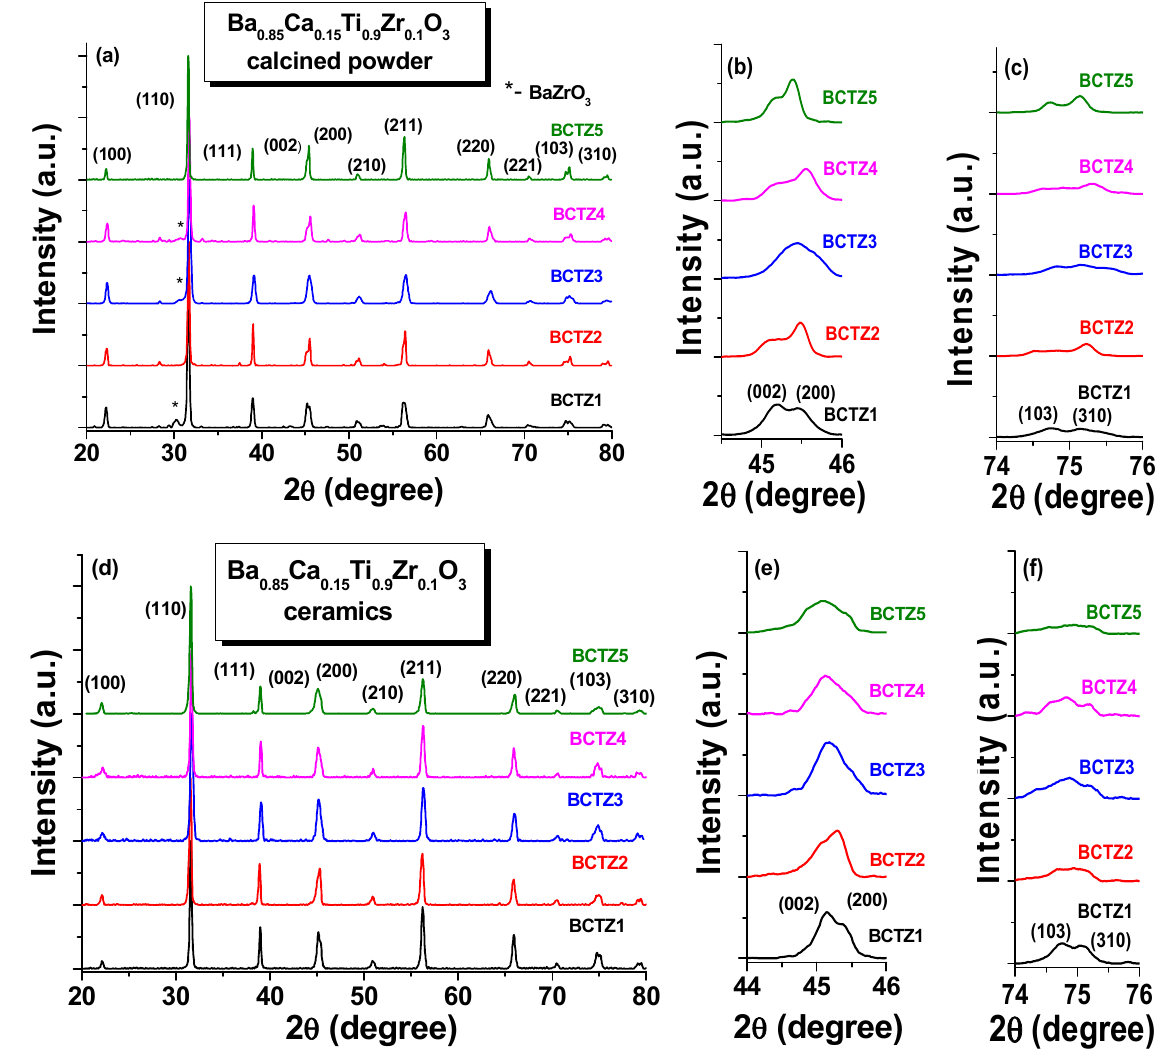
Figure 1. XRD patterns for BCTZ ( a ) calcinated powders and ( d ) ceramics (the enlarged views of the peaks around ( b , e ) 2 θ ∼ 45° and ( c , f ) 2 θ ∼ 75). Scanning electron microscopy (SEM) micrographs performed on the fresh fractured surfaces illustrate the microstructural features of BCTZ ceramics sintered by conventional (Figure 2a–d) and Spark plasma sintering methods (Figure 2e). As one can observe in Figure 2a,b, the ceramic samples BCTZ1 and BCTZ2 obtained by manual and ball milling of the precursor’s powders are less dense than the other ones. Indeed, their relative density determined by the Archimedes method by considering a theoretical density of 5.687 g/cm 3 [45] are similar for BCTZ1 and BCTZ2, of 75% (BCTZ1) and 76% (BCTZ2) and strongly increases for the other samples, reaching 96% (BCTZ3), 95% (BCTZ4) and 97% (BCTZ5). All the BCTZ ceramics exhibit large grains with an average grain size of around 10–20 µ m, including the BCTZ5 ceramic sintered by SPS by using powders subjected to two calcination steps at 1200 ◦ C for 24 h and 1350 ◦ C for 6 h, with intermediate manual milling